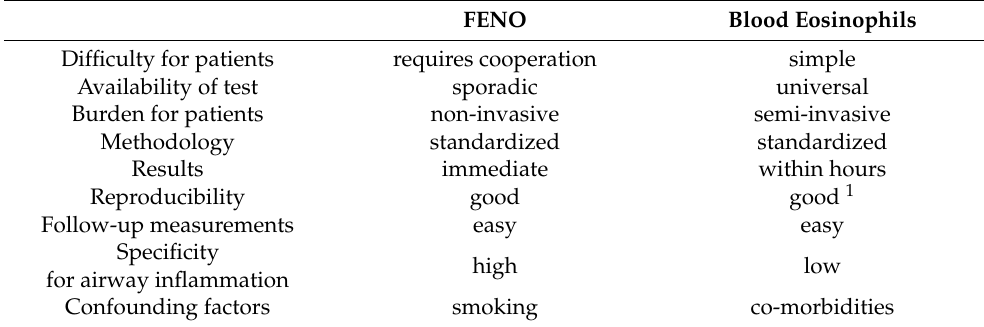
Table 1. Advantages and disadvantages of measuring fractional exhaled nitric oxide (FENO) levels and peripheral blood eosinophil counts in patients with COPD. FENO Blood Eosinophils Difficulty for patients requires cooperation simple Availability of test sporadic universal Burden for patients non-invasive semi-invasive Methodology standardized